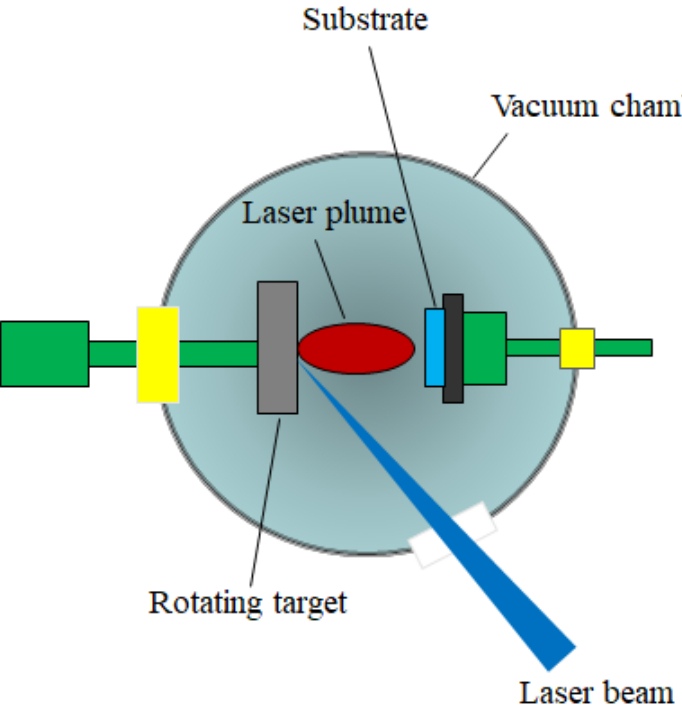
Figure 3. Pulsed laser deposition (PLD) technique scheme Adapted from Ref. [84].